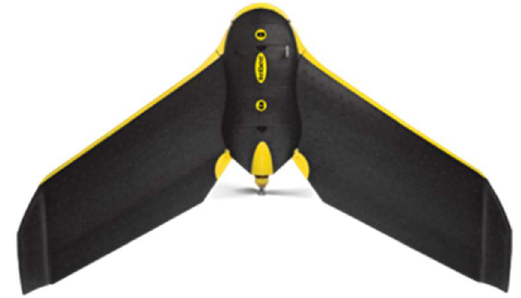
Figure 2. UAV eBee Plus